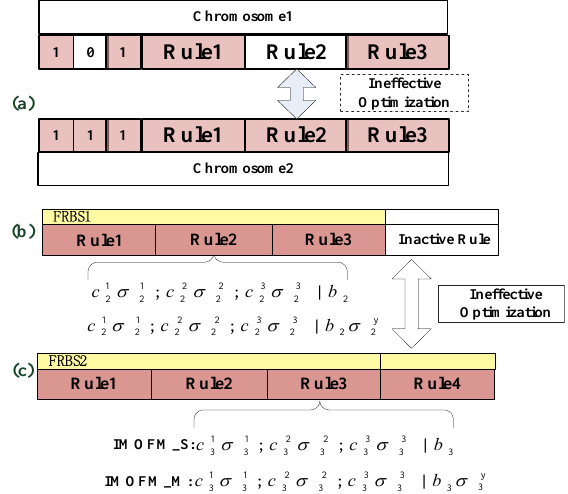
Fig. 3. (a) Ineffective optimisation caused by the interaction of inactive gene (deactivated by 0) and active gene (activated by 1); (b) and (c) variable length coding scheme for a 3-rule Singleton/Mamdani FRBS and a 4-rule Singleton/Mamdani